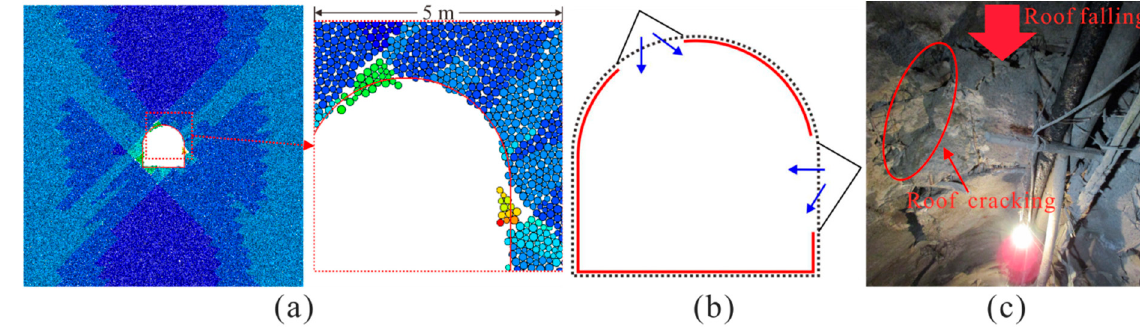
Figure 14. Schematic diagram of collapse failure. ( a ) Numerical simulation result; ( b ) Failure mechanism; ( c ) Field repre-